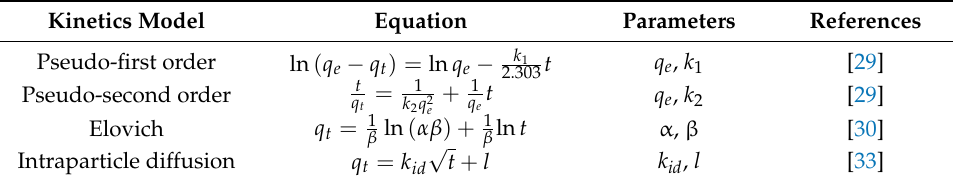
Table 1. Kinetic models investigated for the adsorption of Zn 2+ and As 3+ . Kinetics Model